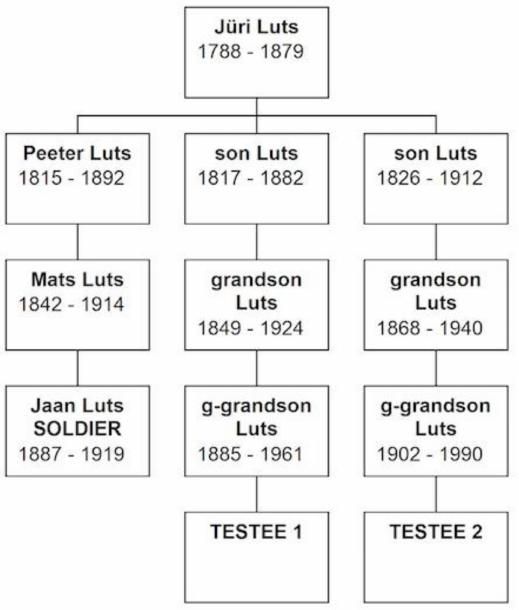
Figure 1. The descendant chart for the identification of an unknown